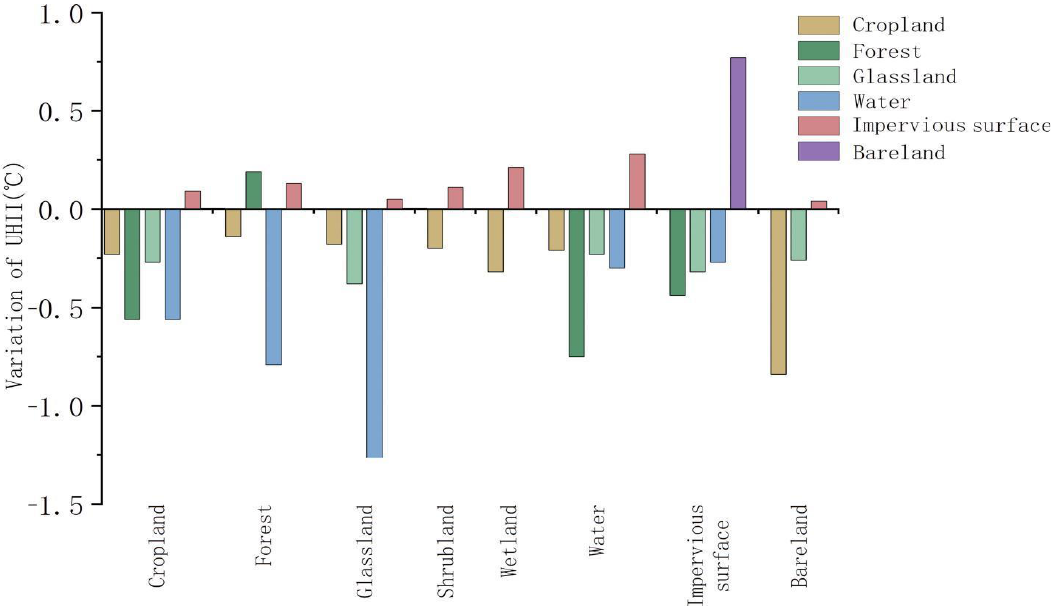
Figure 6. Variation of UHII in different land cover zones from 2014 to 2019